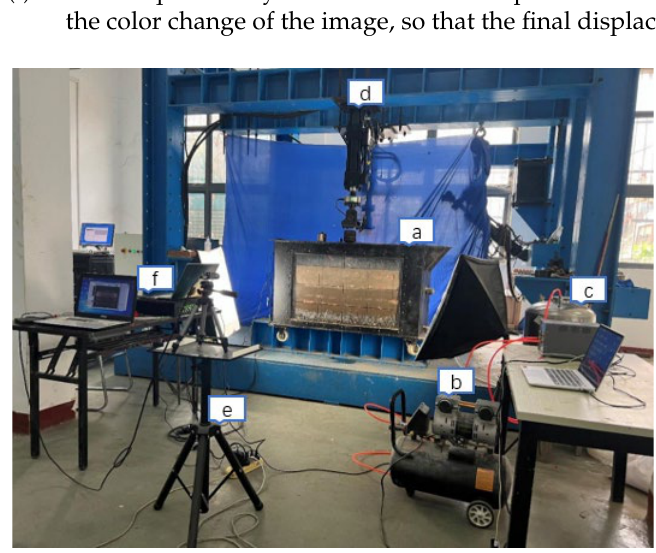
Figure 2. Model box test equipment.